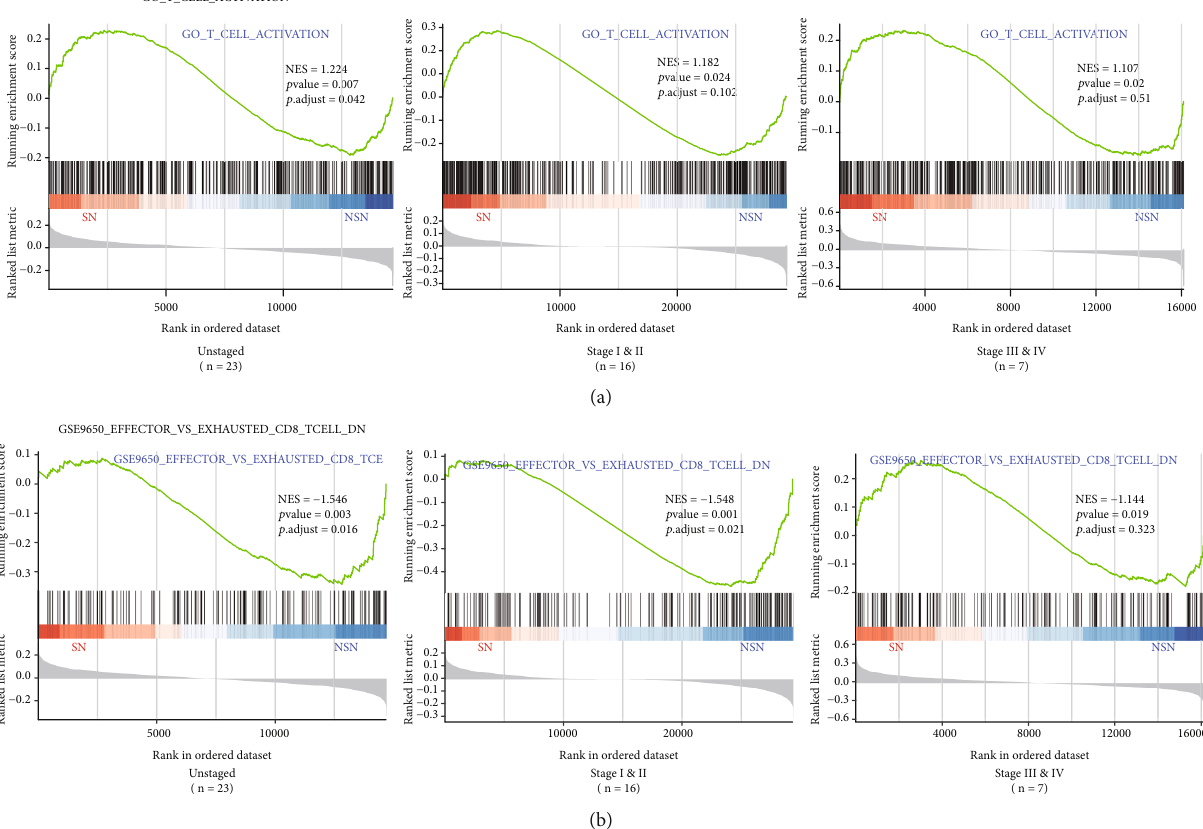
Figure 5: GSEA enrichment analysis of signatures of T cell activation genes (a) and CD8+ T cell exhaustion-related genes